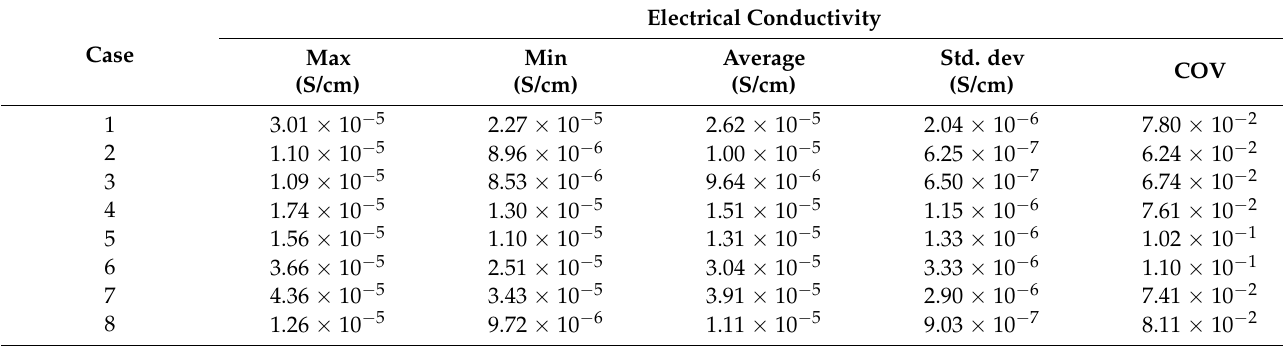
Table 8. Results of electrical conductivity tests for Cases